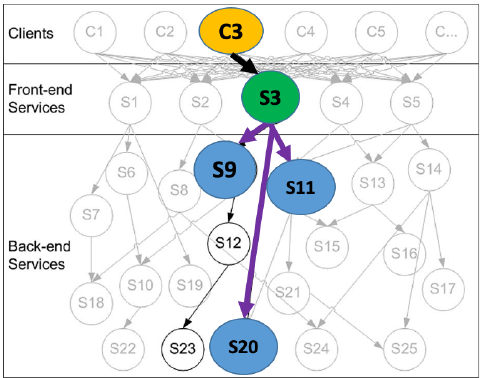
Figure 3. Multi-service dependency between different services